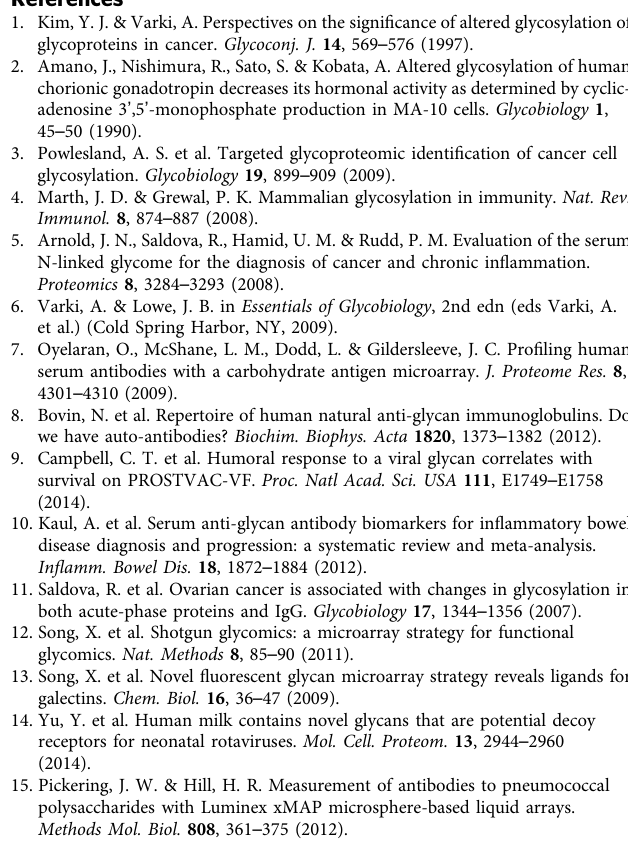
Data availability . All the relevant data are available from the authors upon